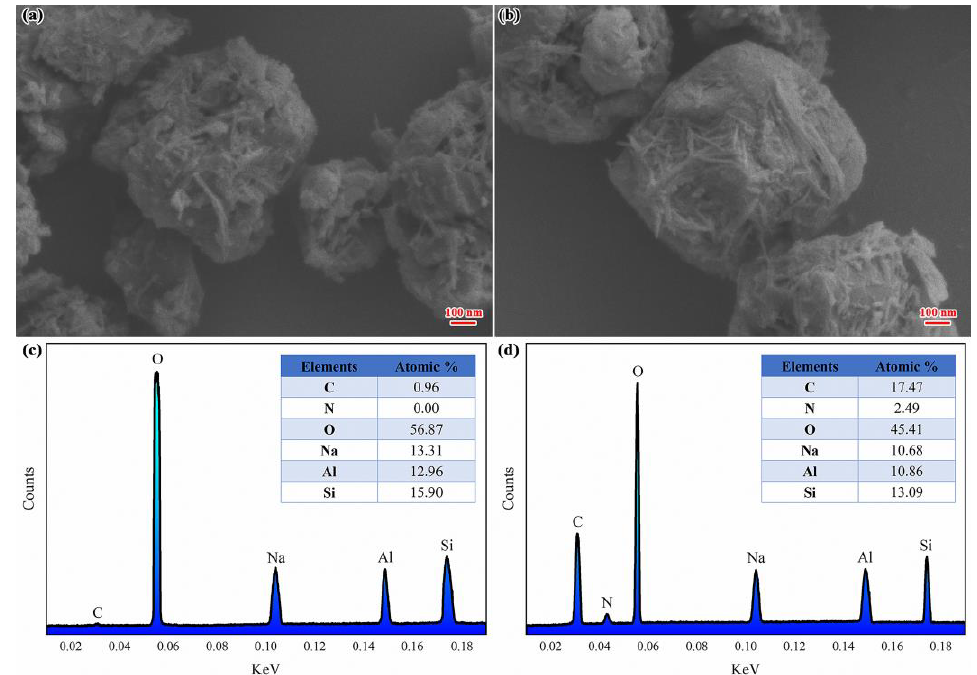
Figure 2. SEM photos of ( a ) ZEO and ( b ) RBA/ZEO and energy dispersive spectroscopy (EDS) of C, N, O, Na, Al, Si in ( c ) ZEO and ( d ) RBA/ZEO.